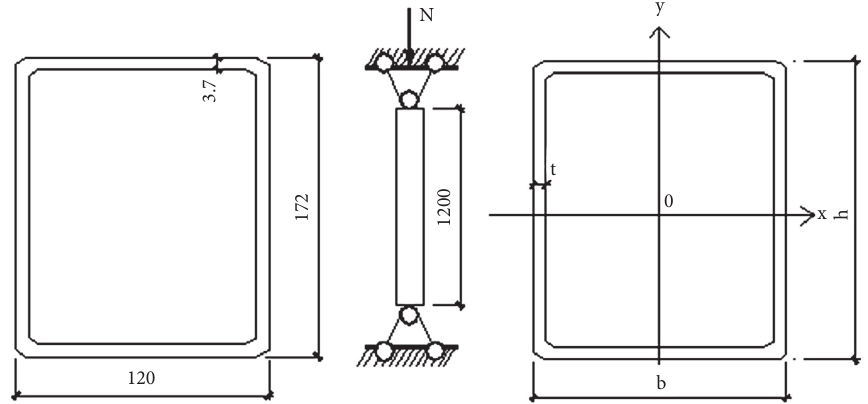
Figure 29: CF-type